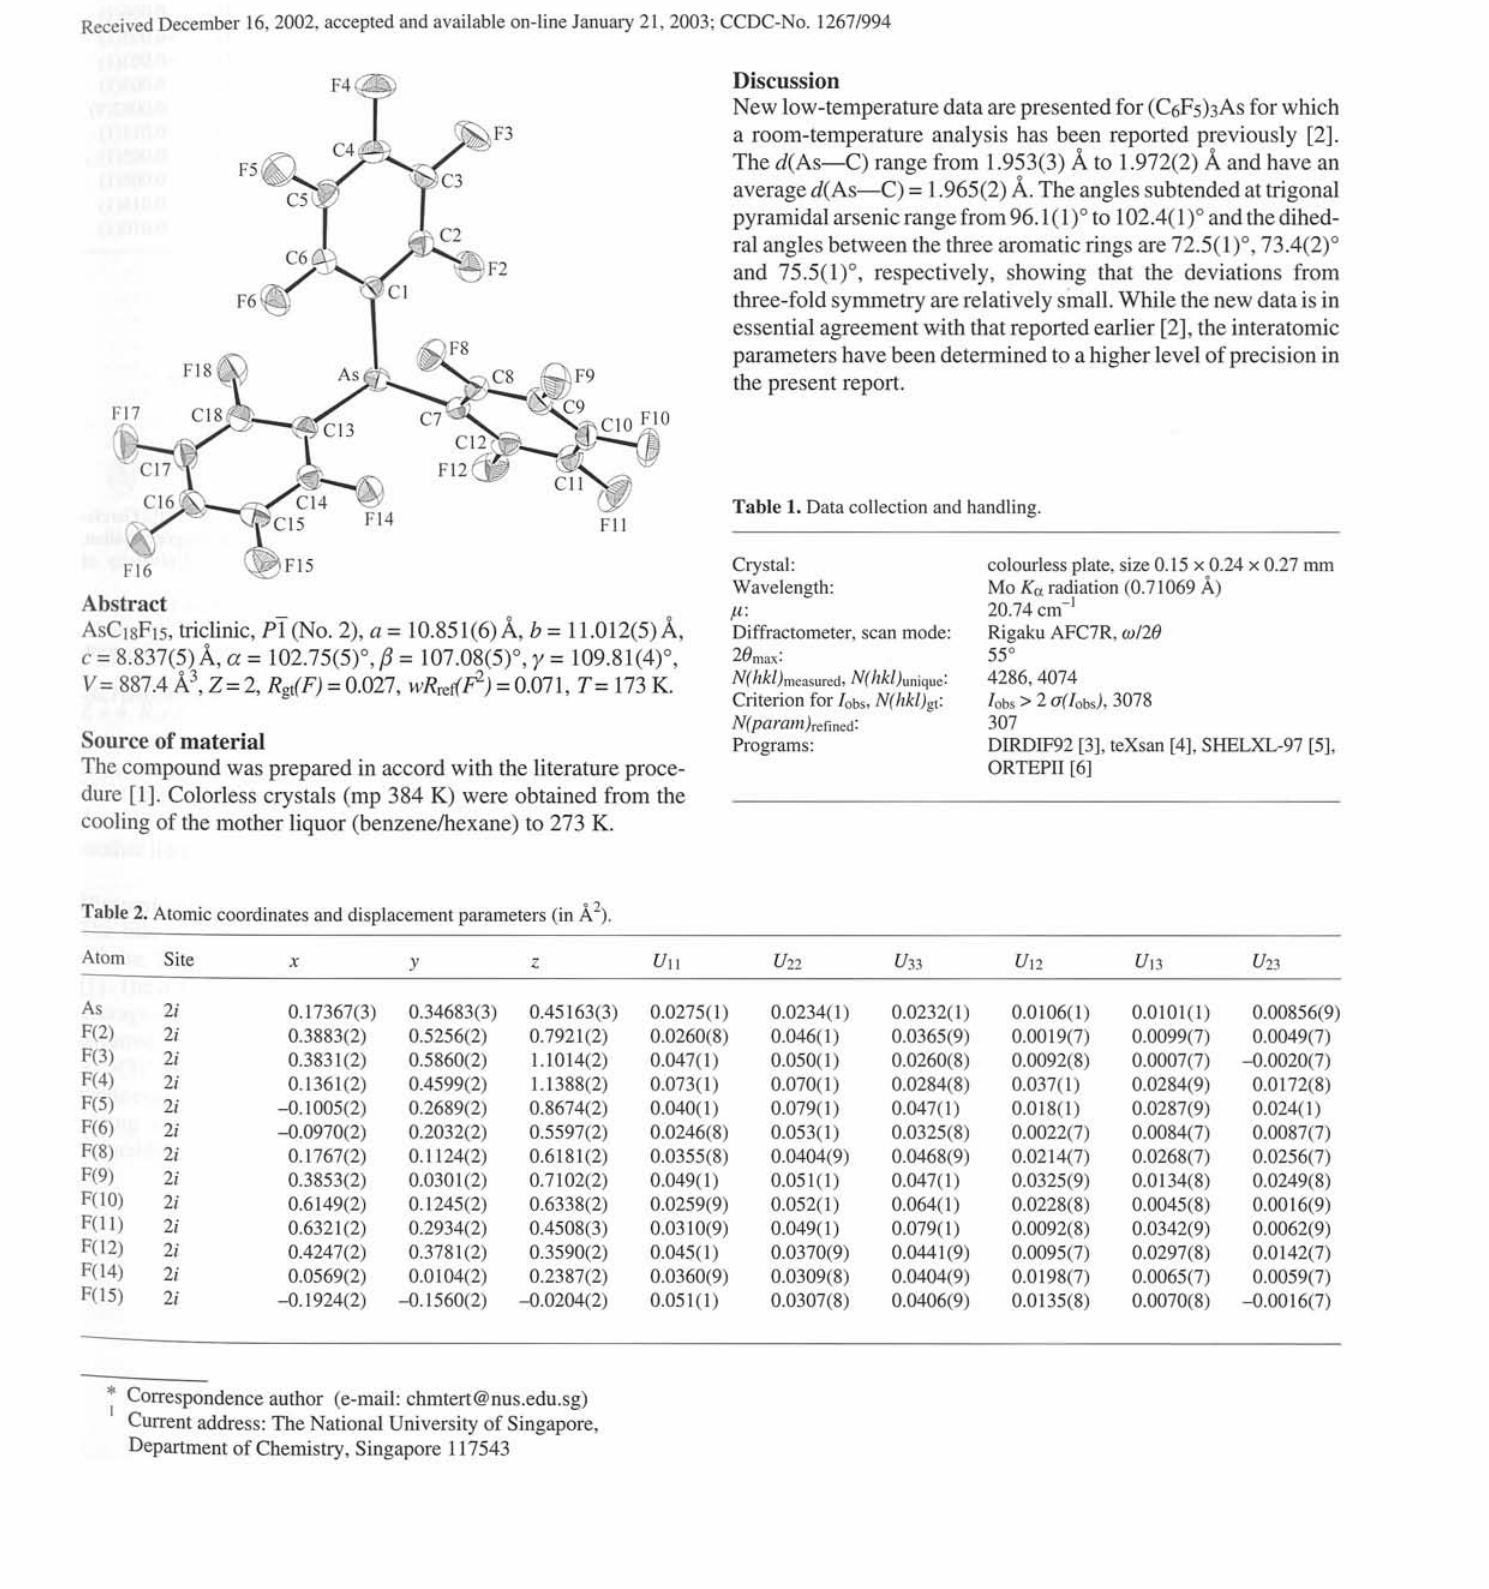
Table 2. Atomic coordinates and displacement parameters (in Â 2